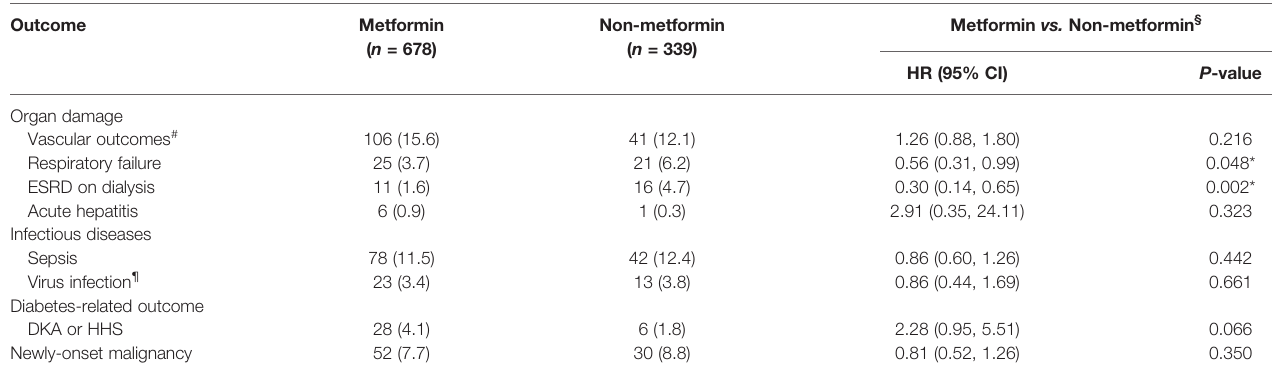
TABLE 3 | Secondary outcome between metformin and non-metformin